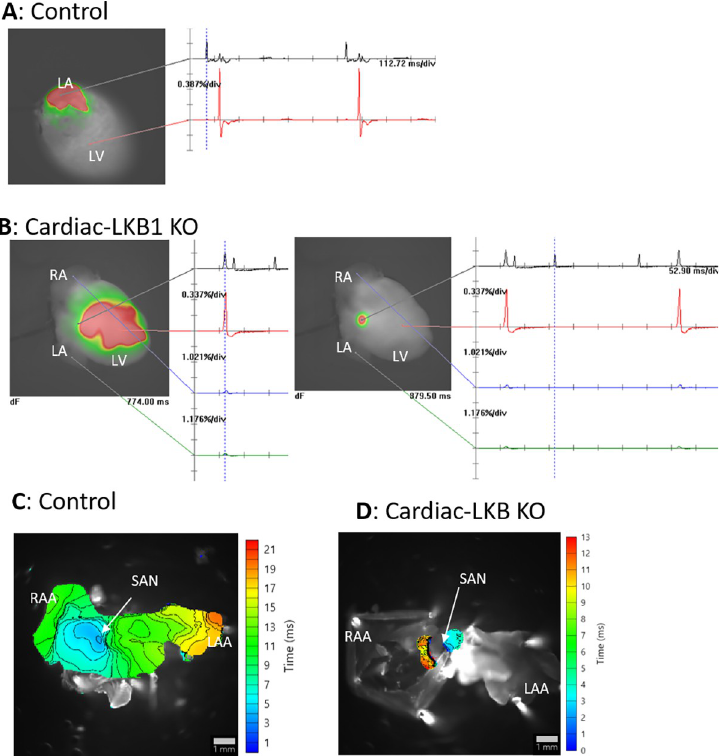
Fig 5. Optical mapping of control and Cardiac-LKB1 KO mouse hearts. A: Representative image of a perfused control mouse heart. LA excitation was detected, and the heart was in sinus rhythm. B: Representative images of perfused Cardiac-LKB1 KO mouse hearts. No atrial excitation was detected and ventricular excitation was confirmed (left). The right image shows a focal area close to atrial septum that was excited independently and irregularly. C: Representative activation map of control mouse atria. Excitation was initiated from the SAN, then propagated though the RA and LA and ended in the RAA and LAA. D: A representative activation map of Cardiac-LKB1 KO mice atria. Excitation was observed only at SAN area; the excitation did not propagate through the atria.